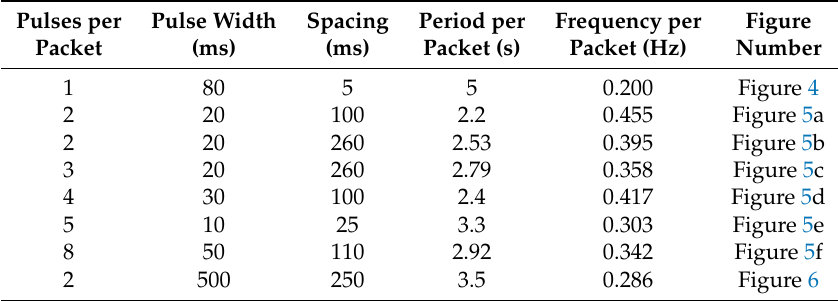
Figure 6. Spike train with packets of 2 long pulses of 0.5 s duration. Table 1. Data from measurements performed during the